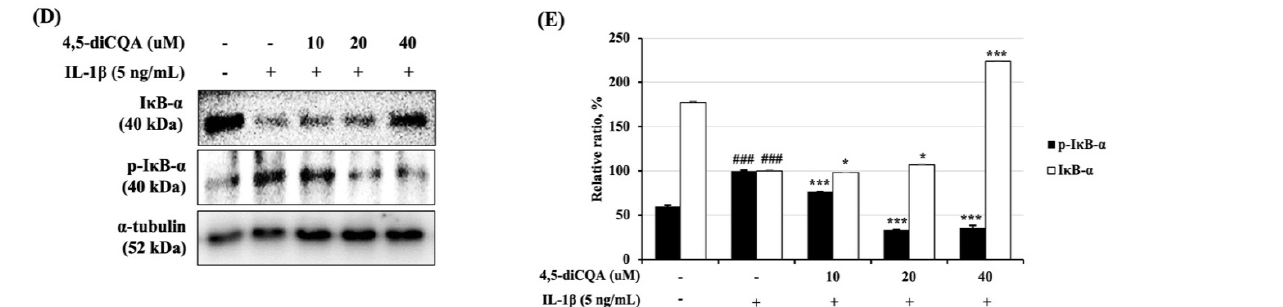
Figure 5. Effects of 4,5-diCQA on IL-1 β -induced activation of NF- κ B in rat primary chondrocytes. Cells were pre-treated with 4,5-diCQA (10, 20, and 40 µ M) for 1 h, followed by IL-1 β (5 ng/mL) stimulation for 1 h. ( A ) Phosphorylation levels of I κ B- α and NF- κ B p65 translocation to the nucleus were determined using Western blot analysis. α -Tubulin and PCNA were used as cytosolic and nuclear internal controls, respectively. ( B , C ) Quantitative data of ( A ) were analyzed using ImageJ bundled with Java 1.8.0_172 software. ( E ) Quantitative data of ( D ) were analyzed using the ImageJ bundled with Java 1.8.0_172 software. n = 5 per group. Data are represented as mean ± SD of three independent experiments. ## p < 0.05 and ### p < 0.005 vs. control group; * p < 0.5, and ** p < 0.05, and *** p < 0.005 compared with the IL-1 β -treated group.